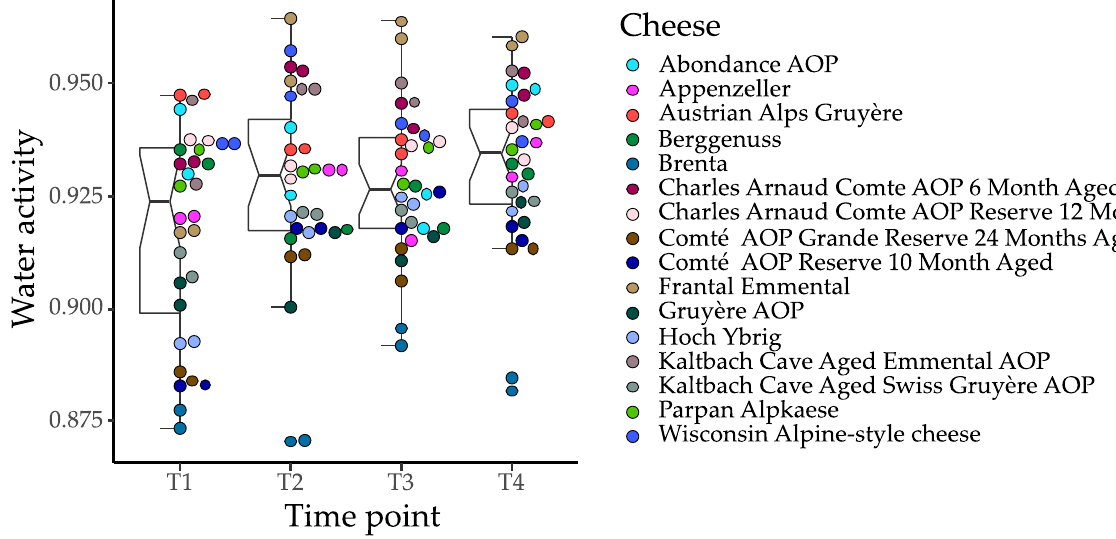
Figure 3. Changes in water activity in 16 types of tested cheeses over six weeks of refrigerated storage measured at four time-points.